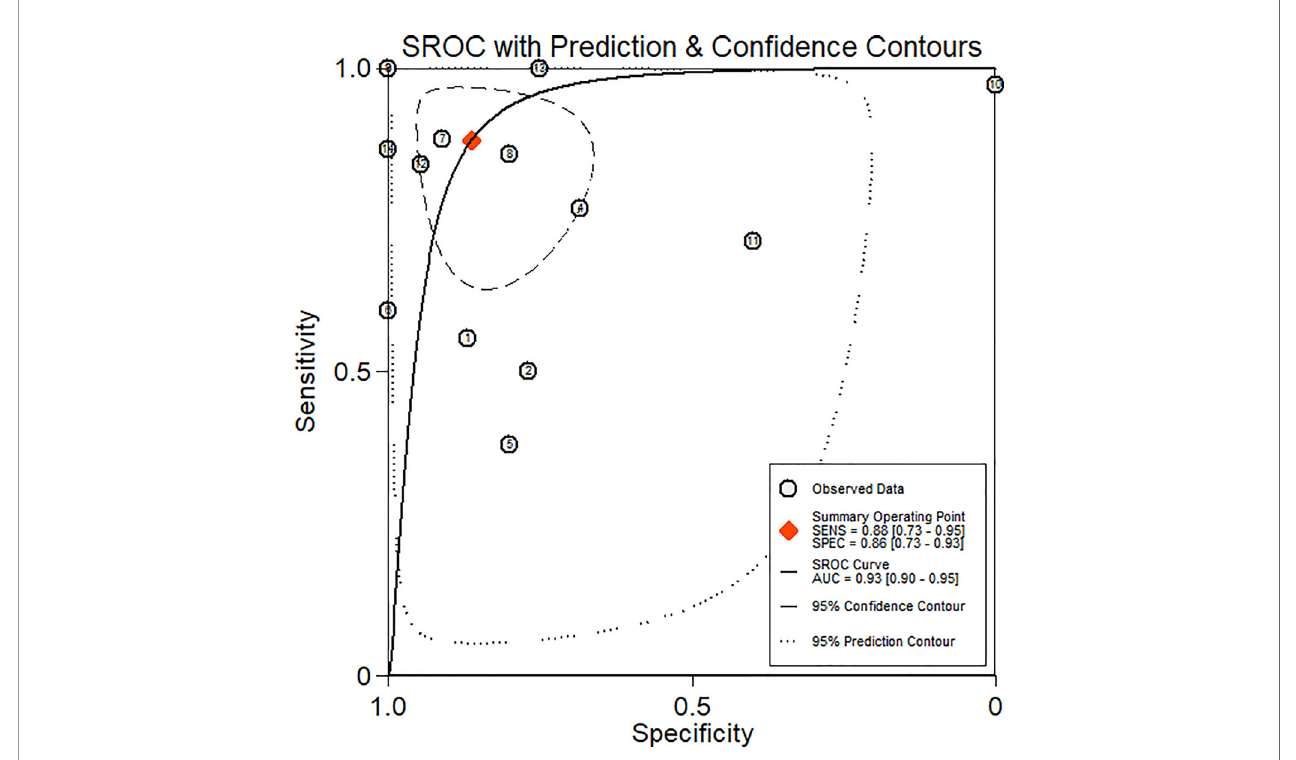
FIGURE 5 | Summary receiver operating characteristics curve.